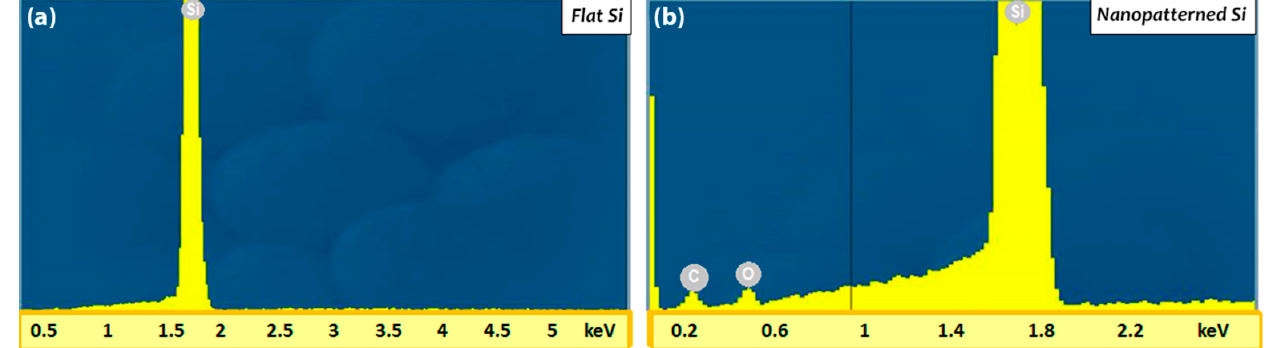
Figure 4. EDS spectrums of Si substrates: ( a ) untreated and ( b ) treated by HR-LIPSS Si substrates.